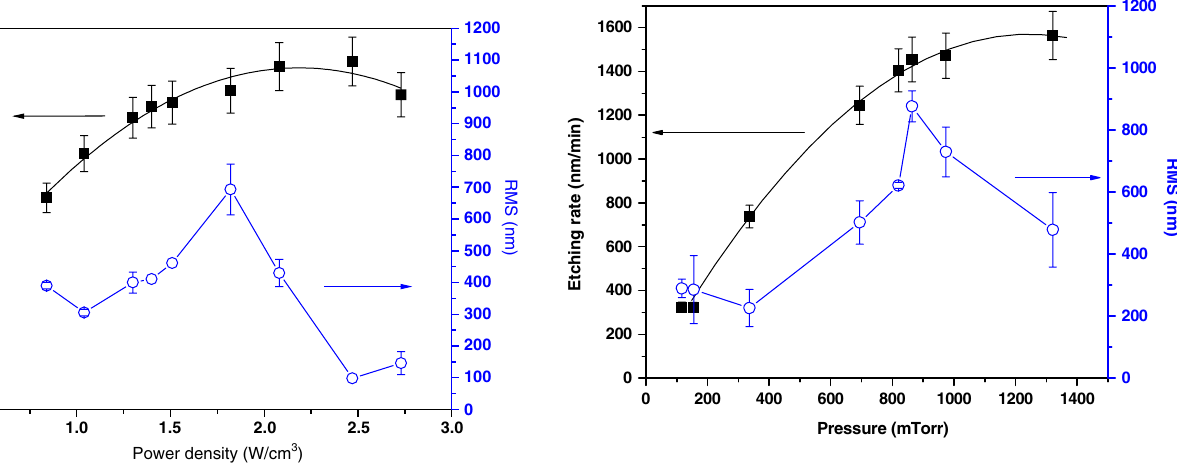
FIG. 2. Etching rate and surface RMS dependence on input power density. Experimental conditions: 3% of Cl 2 in reactive gas mixture and pressure in reaction chamber 340 mTorr.